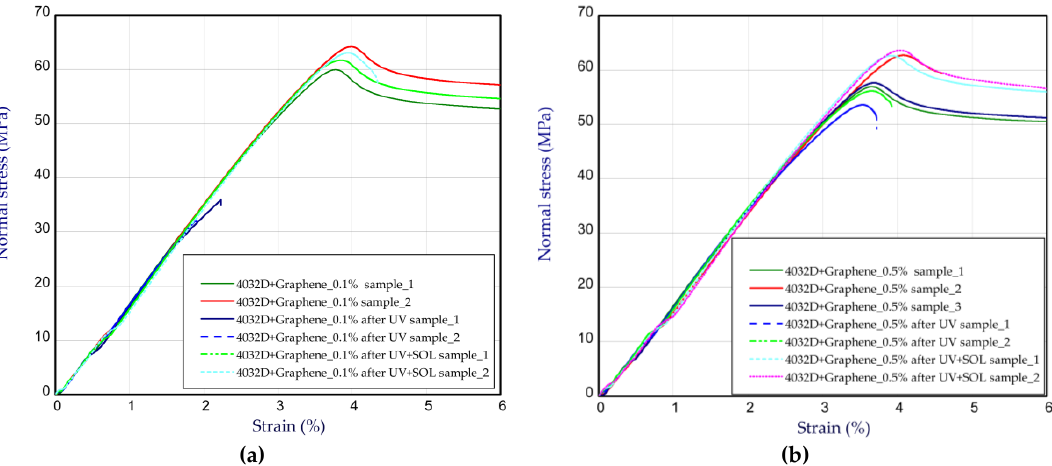
Figure 9. The curves of tensile tests for samples 4032D admixed with graphene at 0.1 wt.% ( a ) and 0.5 wt.% ( b ). Table 2. Characteristic parameters obtained in tensile test for samples 4032D with admixture of GNP. Parameter